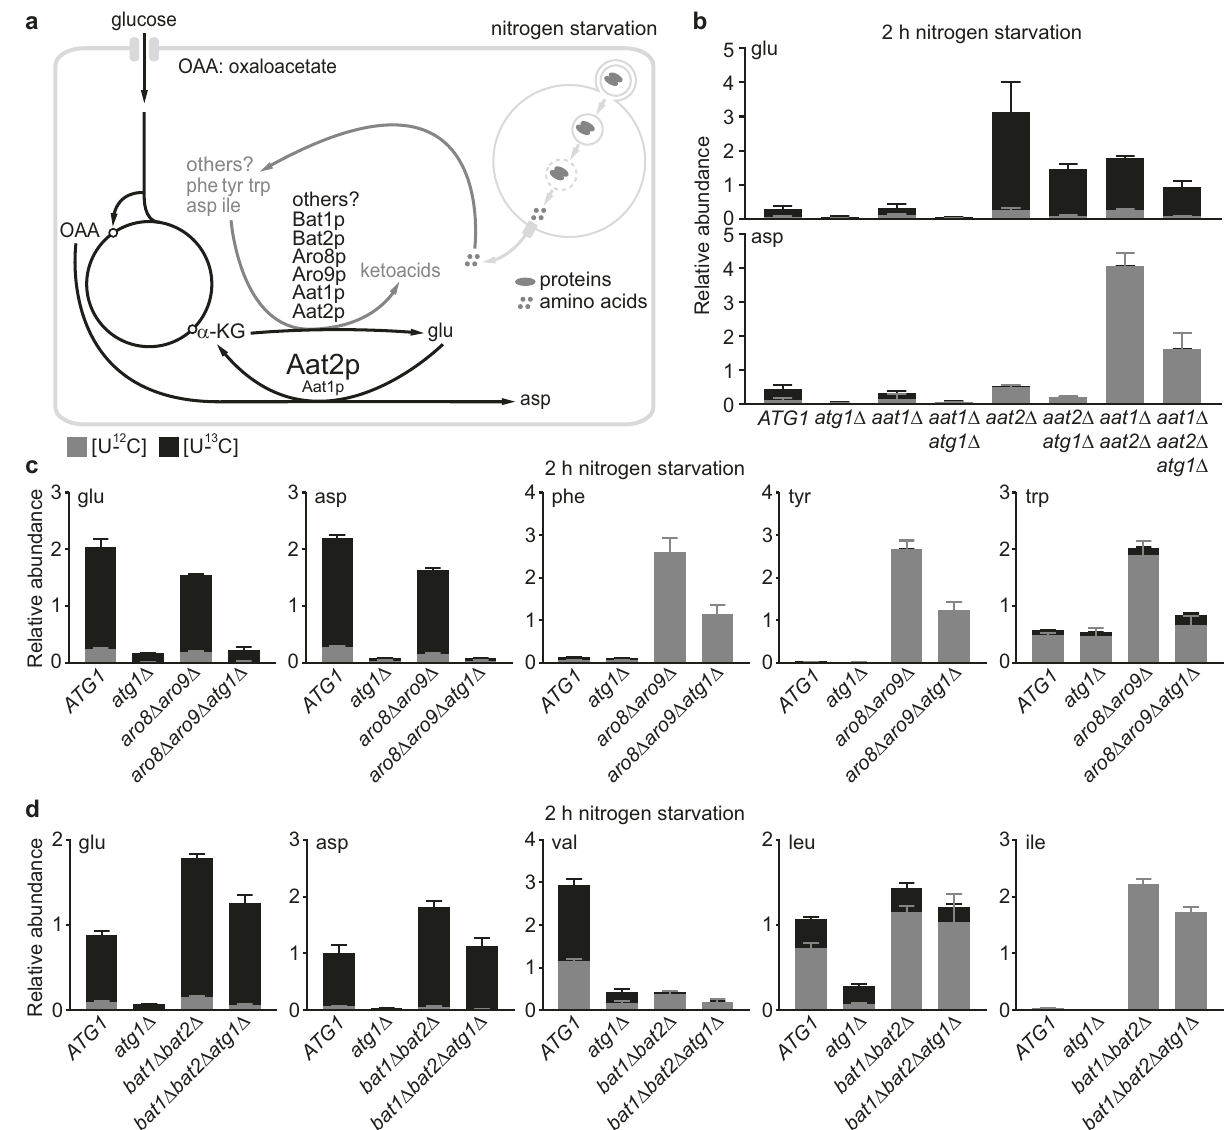
Fig. 6 Aspartate is a major nitrogen investment under nitrogen starvation. a Proposed model for glutamate and aspartate metabolism under nitrogen starvation. Only ammonium-independent glutamate synthesis is shown. The large font for Aat2p indicates that it acts as the major enzyme for aspartate synthesis under nitrogen starvation. b Loss of aspartate synthesis leads to strong accumulation of newly synthesized glutamate. Cells were grown in SD + 10 mM aspartate (pH 5.4) and starved in [U- 13 C]-SD-N for 2 h. Two independent replicates for aat2 Δ atg1 Δ (aspartate), fi ve for aat1 Δ aat2 Δ atg1 Δ , and three for the remaining strains. c Loss of phenylalanine and tyrosine synthesis does not signi fi cantly affect newly synthesized glutamate under nitrogen starvation. Cells were grown in SD + phenylalanine, tyrosine, and tryptophan at 1 mM each and shifted to [U- 13 C]-SD-N for 2 h. The aro8 Δ aro9 Δ mutant is not auxotrophic for tryptophan, as evidenced by the detection of [U- 13 C]-tryptophan under nitrogen starvation. Nonetheless, we supplemented tryptophan to compare it with phenylalanine and tyrosine as an amino-group donor for glutamate synthesis under nitrogen starvation. Three independent replicates. d Loss of valine and isoleucine synthesis led to modest accumulation of newly synthesized glutamate under nitrogen starvation. Strains were grown in SD + isoleucine, leucine, and valine at 1 mM each and shifted to [U- 13 C]-SD-N for 2 h. Three independent replicates. The presence of [U- 13 C]-leucine in the bat1 Δ bat2 Δ mutant indicates the existence of additional enzyme(s) for leucine synthesis. Data are presented as mean ± standard